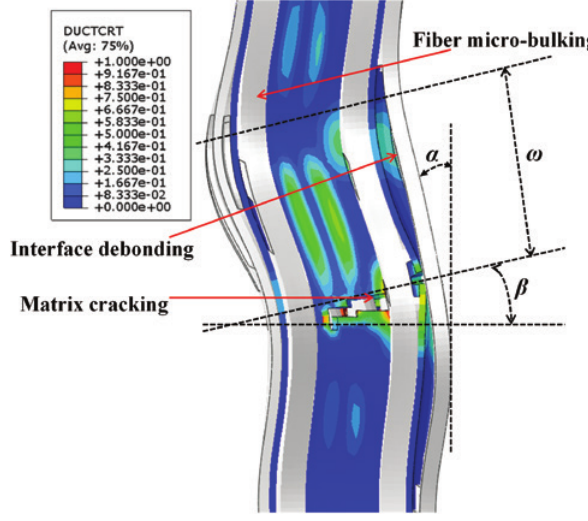
Figure 8: The deformation and damage propagation during the kink-band